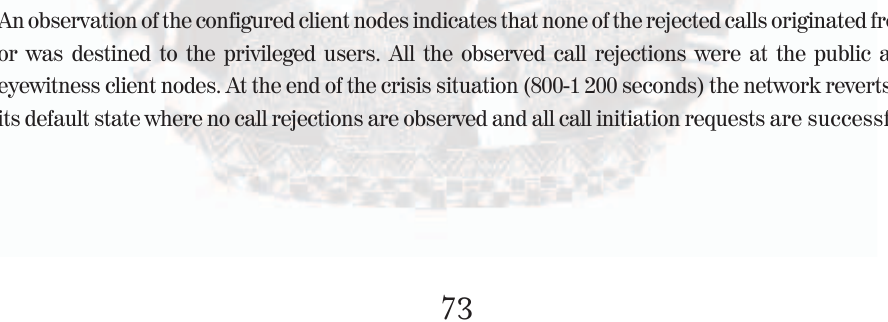
FIGURE 13: TOTAL CALLS CONNECTED, REJECTED, AND REQUESTED AS OBSERVED AT THE SIP